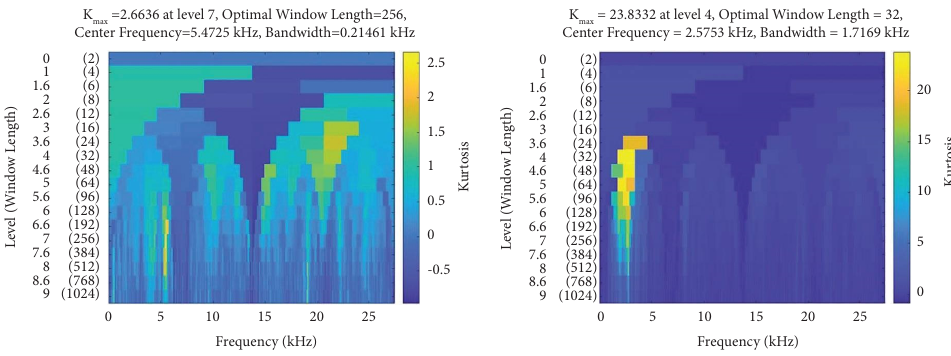
Figure 7: Kurtogram of IRMF.